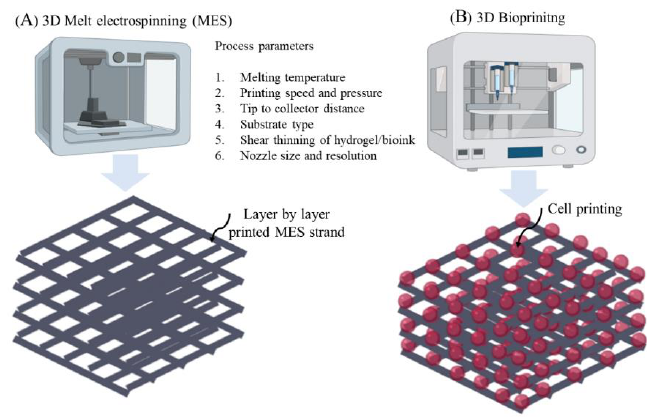
Figure 6. 3D printing setups showing ( A ) 3D Melt electrospinning, and ( B ) 3D